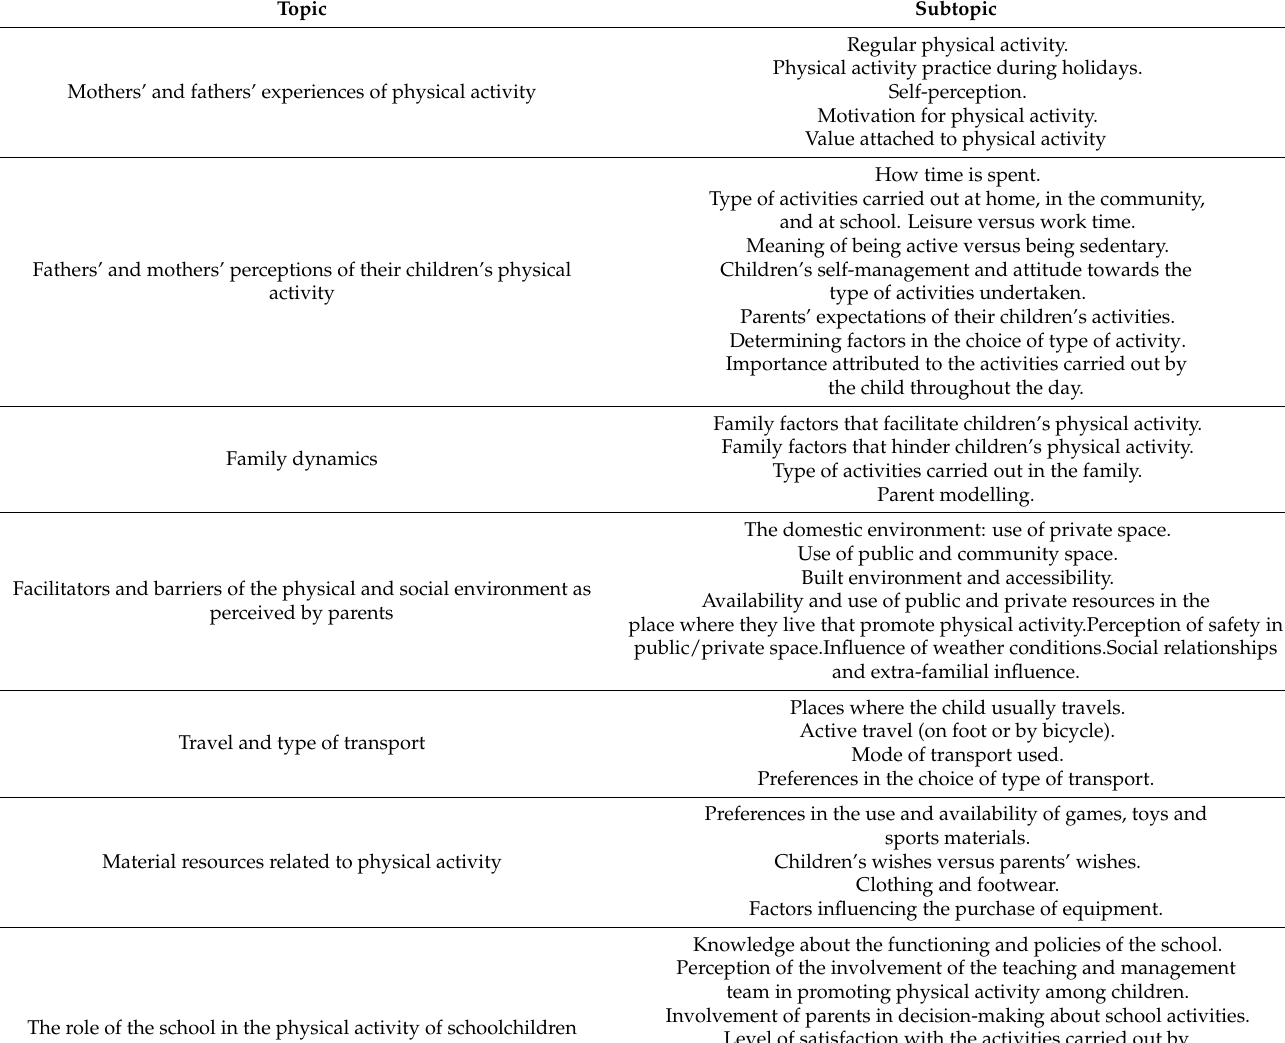
Table 1. Script of topics used in the focus